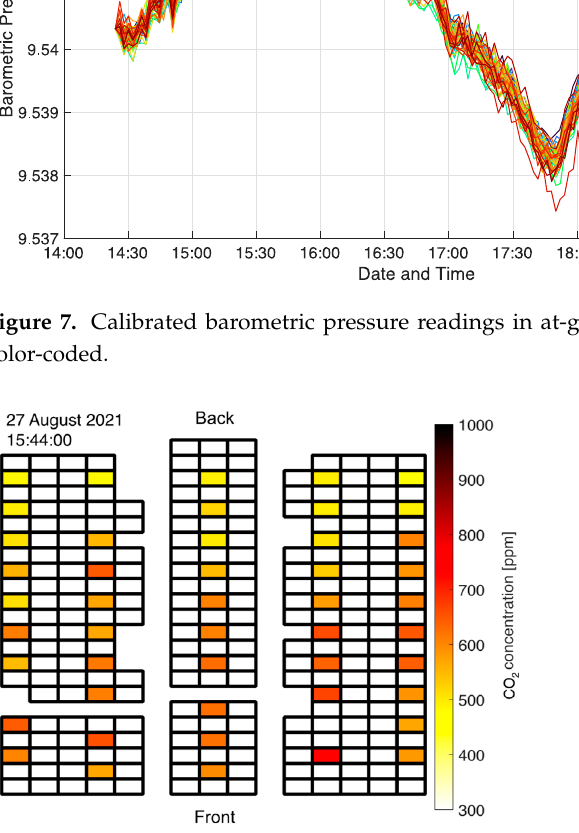
Figure 8. CO 2 concentration gradient from back to front during seating of students prior to exam in at-grade room.